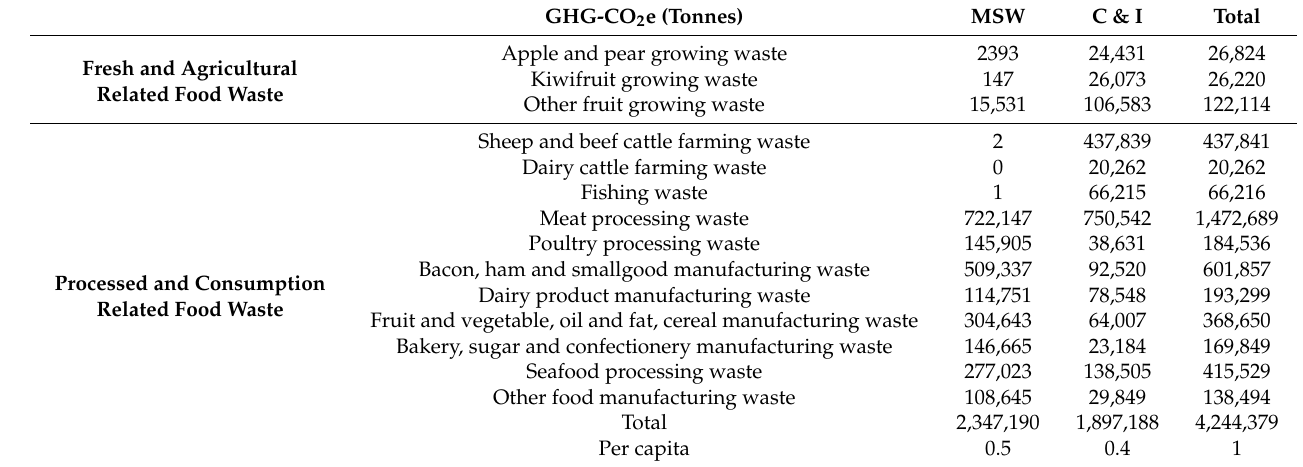
Table 3. Total GHG-CO 2 e (tonnes) embodied in food waste generated in New Zealand in